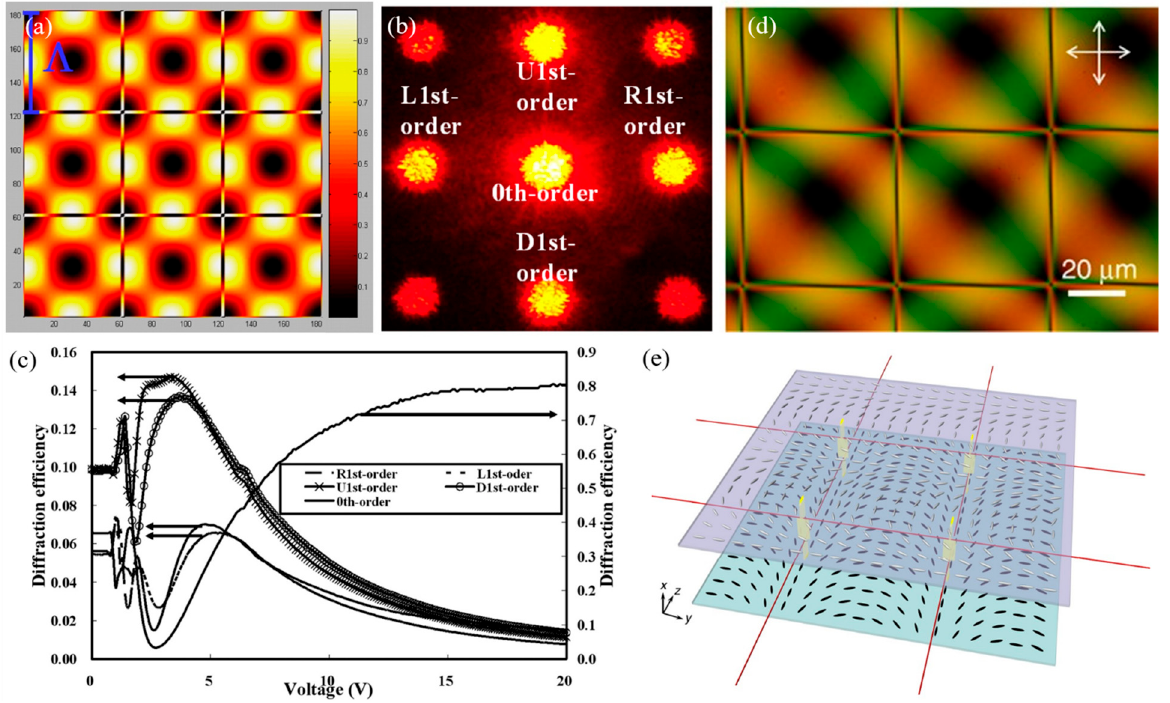
Figure 3. ( a ) Simulated image of a 2D LC PG between crossed polarizers with a square web of disclinations. Diffraction pattern ( b ) and diffraction efficiency ( c ) with the applied ac voltage. ( d ) The square web of disclinations of LC observed by a polarized optical microscope (POM). ( e ) Schematic illustration of the square web of disclination lines in a LC cell. ( a – c ) Reproduced from Reference [32] with permission from AIP Publishing. ( d , e ) Reproduced from Reference [33] with permission from Springer Nature.